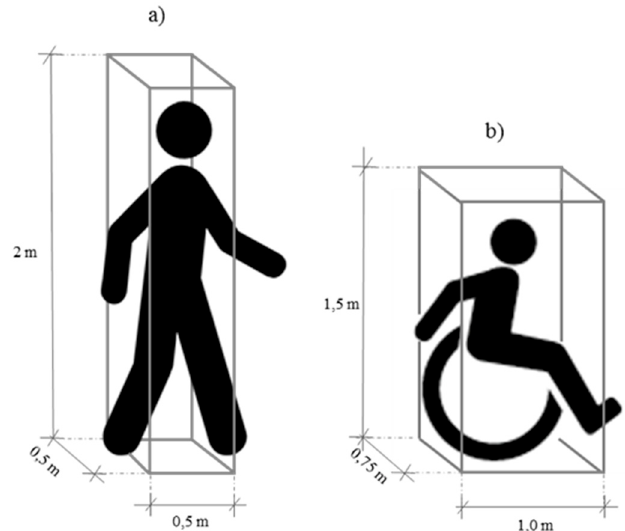
Figure 12. Buffer size for ( a ) walking people and ( b ) people on wheelchairs.